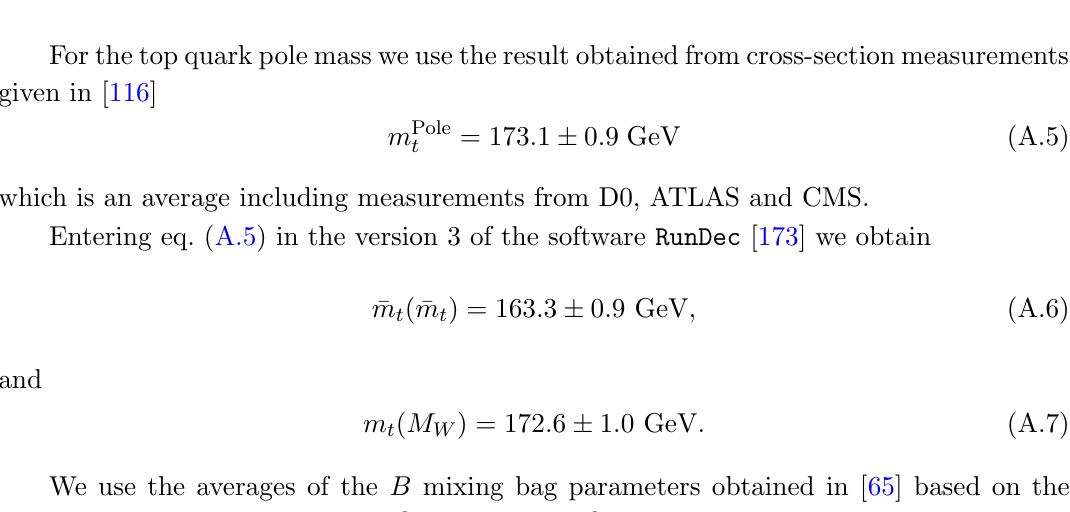
Table 18 . Values of the input parameters used for our numerical evaluations